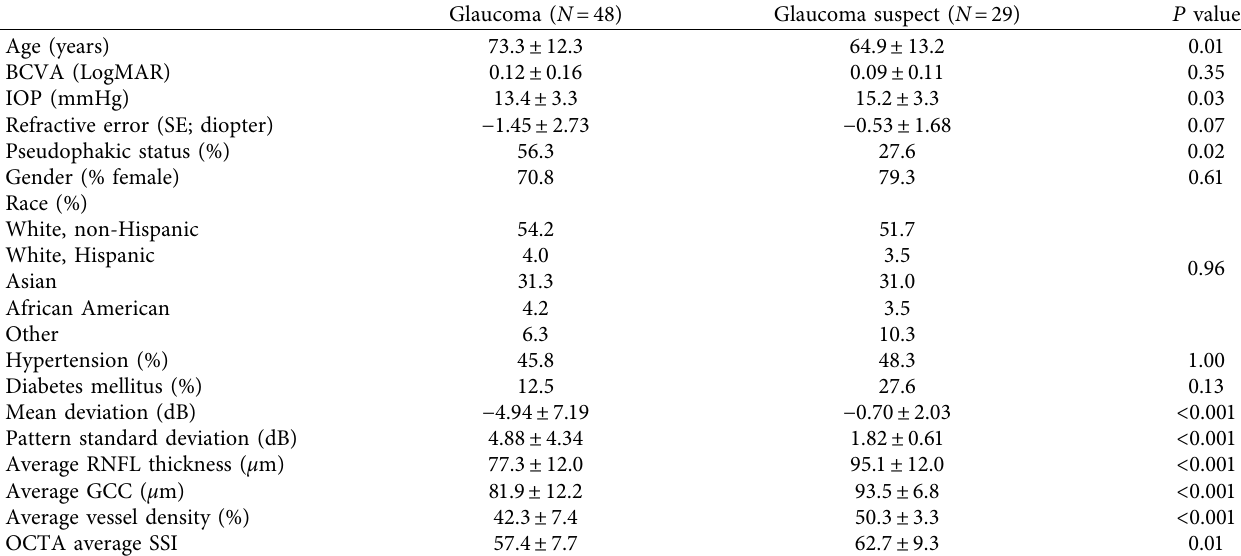
Table 1: Demographics and ocular